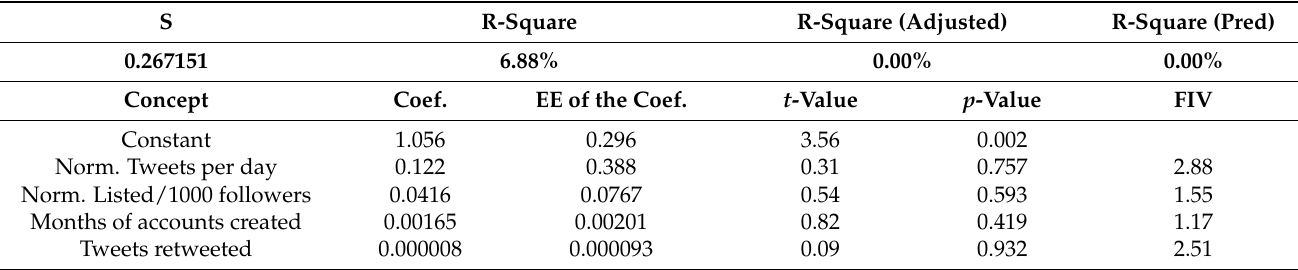
Table 6. Second model